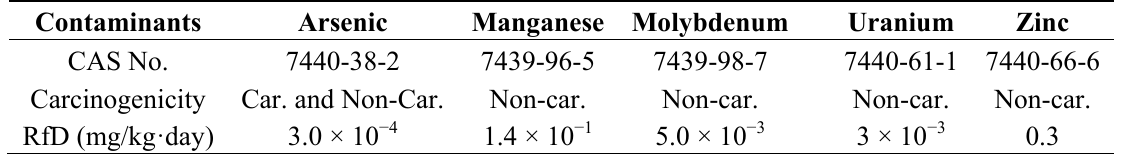
Table 4. Reference dose of exposure for five contaminants [27]. RfD, reference dose. Contaminants Arsenic CAS No. Carcinogenicity Car. and Non-Car.